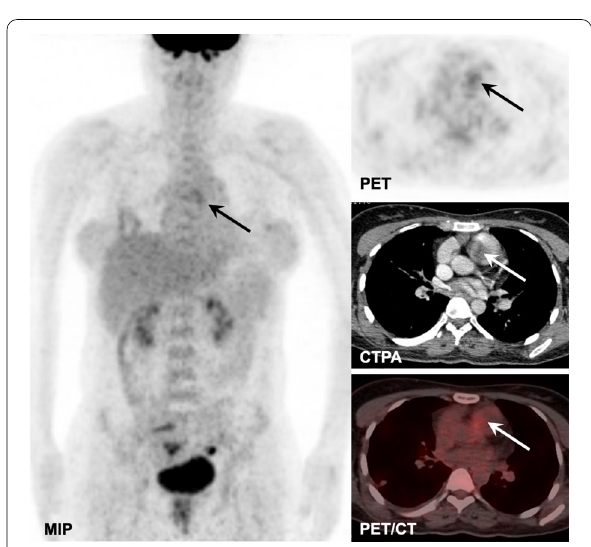
Fig. 2 PAS in a 37-year-old woman involving PT and RPA (solid arrows) with moderate FDG uptake (SUVmax: 3.0) on the MIP, axial PET, and fused PET/CT images, and filling defect on the CTPA